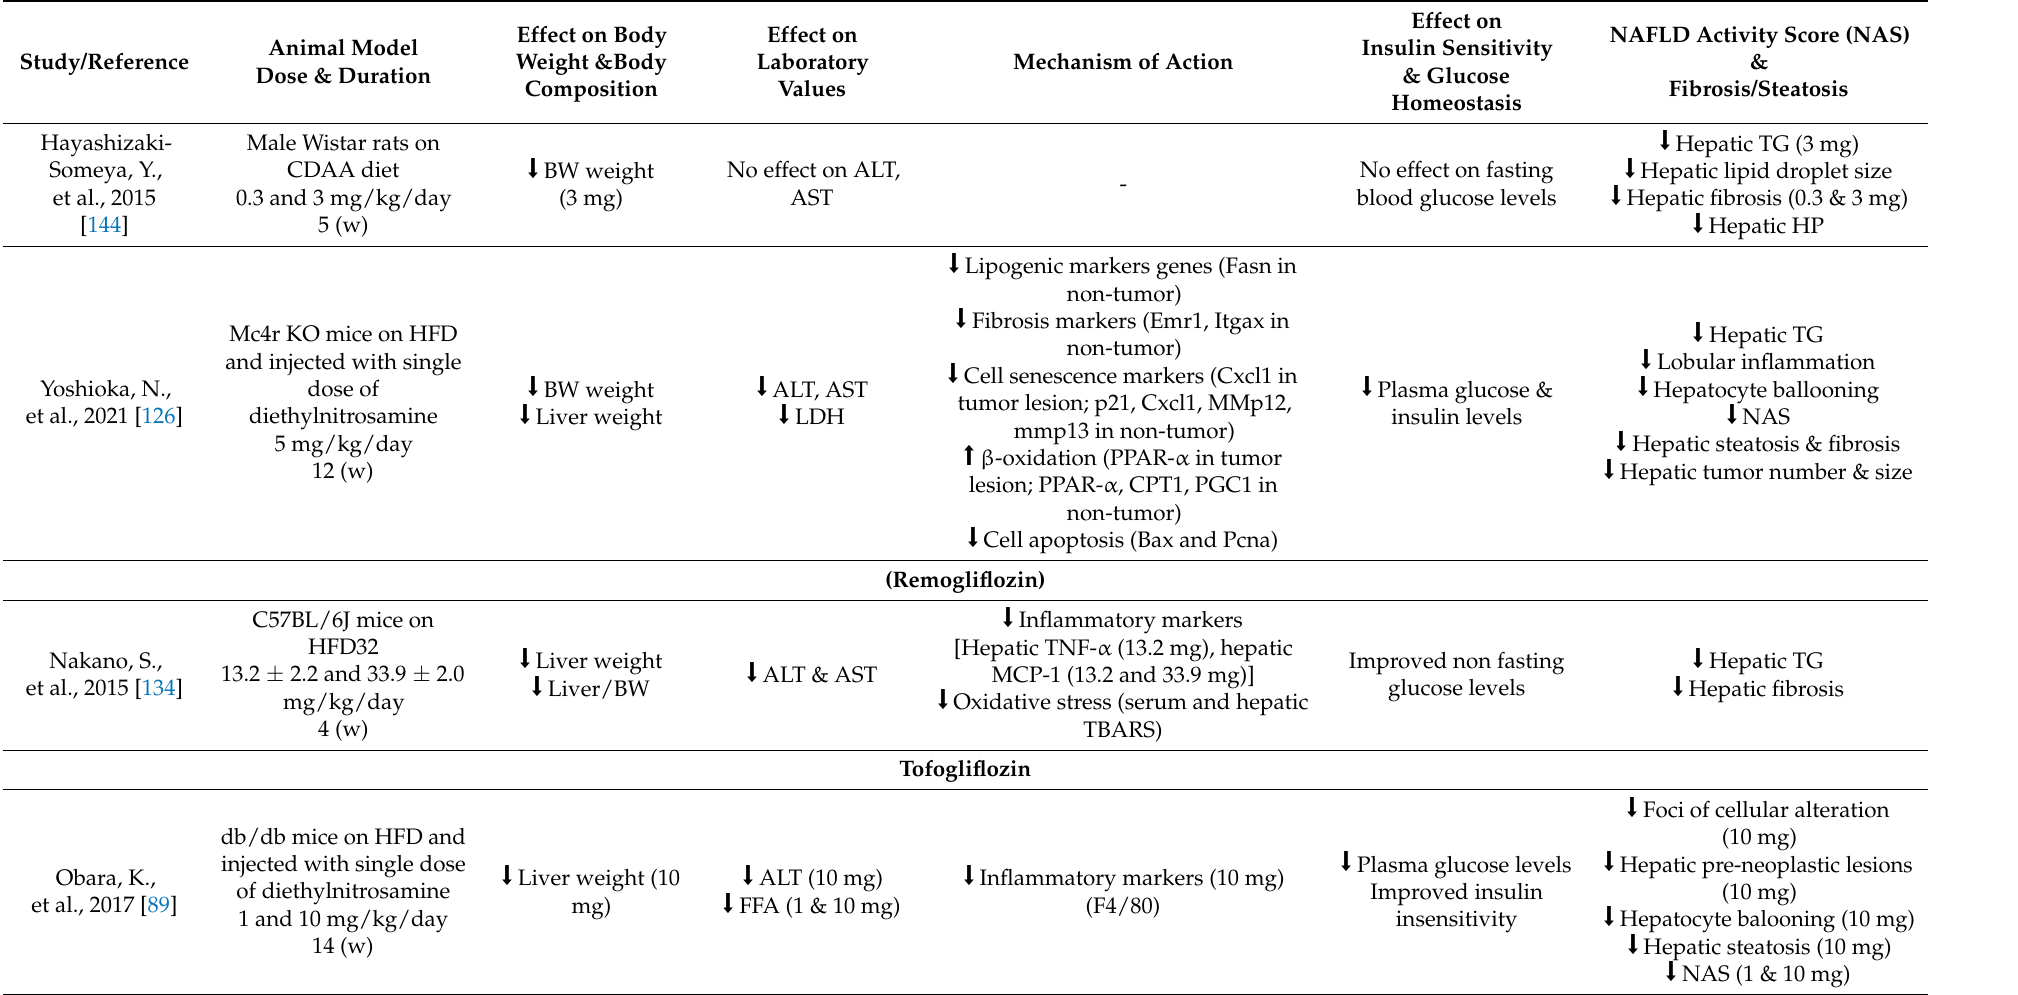
Table 1. Key animal studies regarding the impact of empagliflozin on NAFLD/NASH.